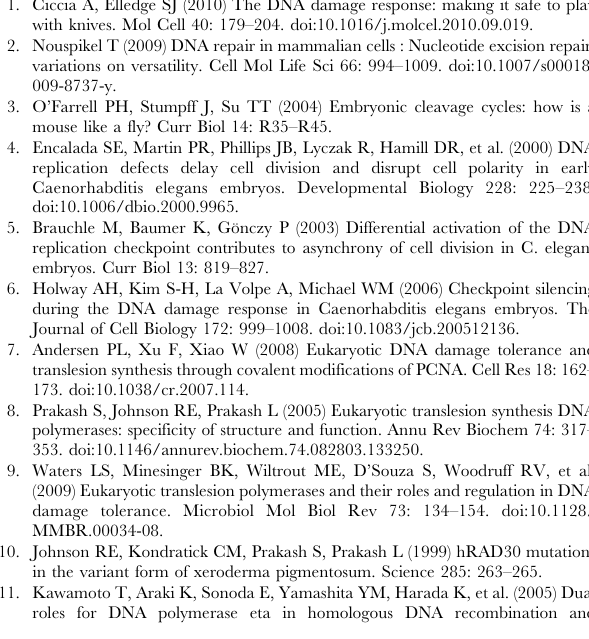
from L1 stage. Each line is the mean of three independent experiments; error bars denote s.e.m. (TIF) Figure S7 Morphological defects in MMS exposed embryos. DAPI-stainings of whole animals exposed for 24 hrs to MMS reveal a delay in development on indicated RNAi foods. Incidentally, chromatin bridges are visible (arrows) indicative of incomplete DNA replication. (TIF) Table S1 List of newly generated strains used in this study. (DOC) Table S2 polh-1 does not influence lethality in a mutant background where transposition is desilenced. Double mutants for the HR gene brc-1 and the mutator gene rde-3 display synthetic lethality while polh-1; rde-3 double mutants are comparable to rde-3 single mutants. a worm exposed for 24 hrs to MMS. Embryo arrests in the first cellular division.